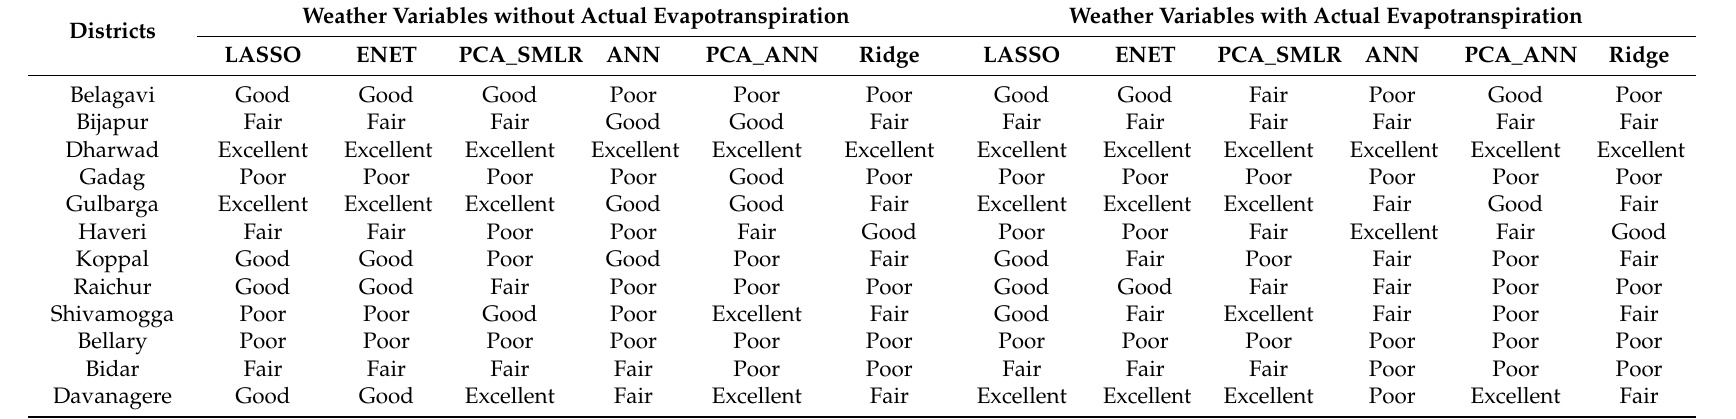
Table 9. Cross comparison of models based on